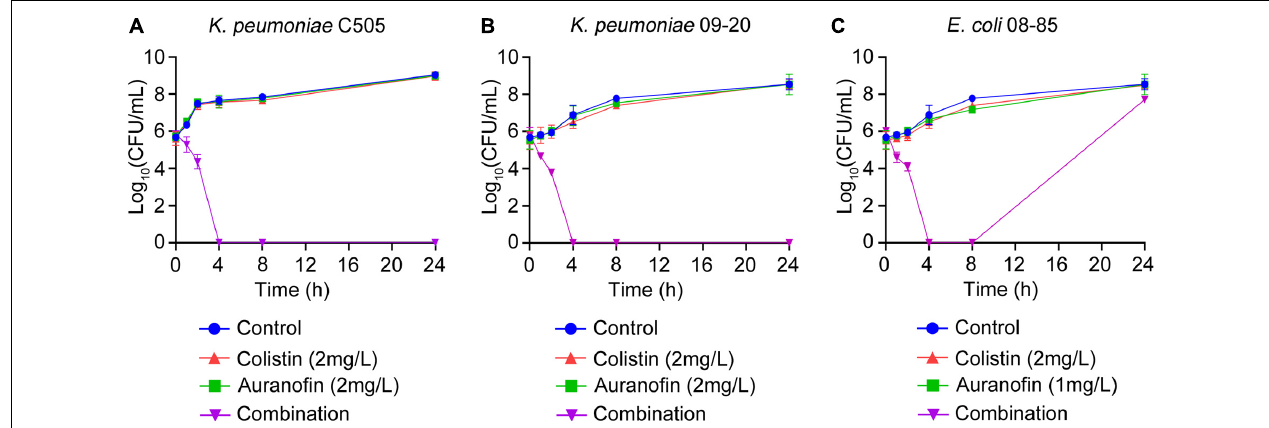
FIGURE 1 | Time-kill assays showing the effects of colistin or auranofin alone or in combination against mcr-8 positive K. pneumoniae C505 (A) , mcr-1 positive K. pneumoniae 09-20 (B) , and mcr-1 positive E. coli 08-85 (C) .